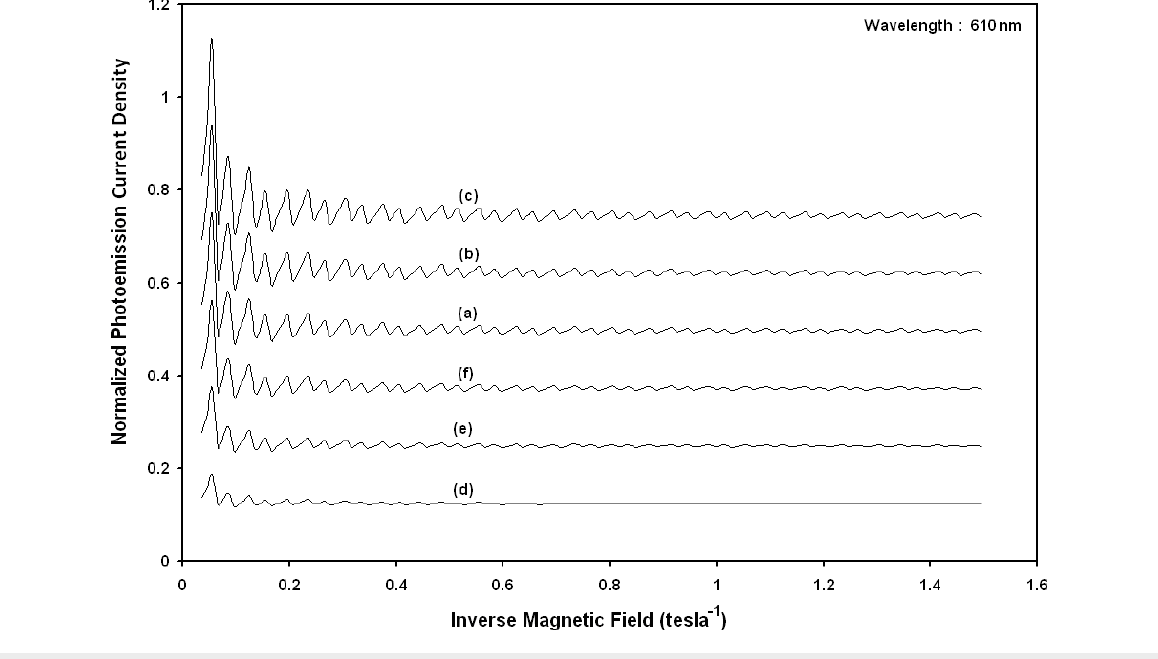
Figure 16: Plot of the normalized photoemission current density from effective mass superlattices of HgTe/Hg 1 − x Cd x Te as a function of inverse magnetic field and in which the curves (a), (b) and (c) represent the perturbed three and two band models of Kane and parabolic energy bands, res- pectively. The curves (d), (e) and (f) exhibit the corresponding plots of In x Ga 1 − x